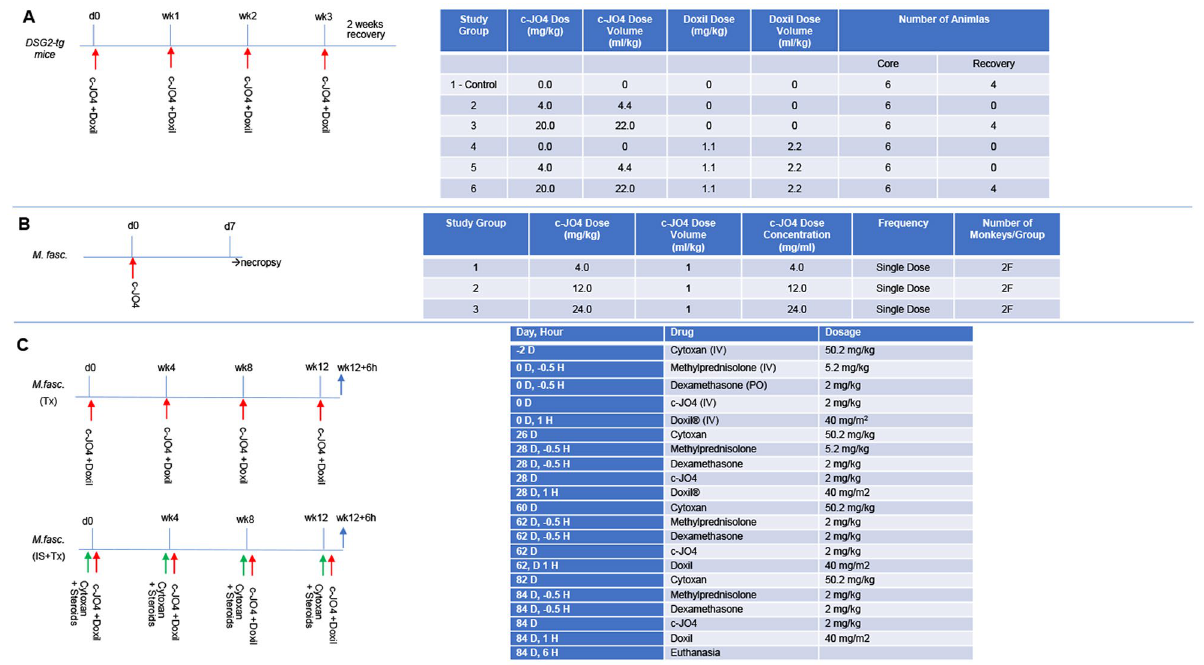
Figure 2. Summary of animal studies. ( A ) Four-week intravenous GLP-toxicology study of c-JO4 in female hDSG2-transgenic mice. The objectives of this study were to evaluate the potential toxicity of c-JO4 when administered intravenously together with Doxil to hDSG2-transgenic mice weekly for 4 consecutive weeks with 2 weeks of recovery. c-JO4 was injected intravenously one hour before intravenous injection of Doxil. The animals were approximately 5–11 weeks old and weighed 19.9–26.0 g at the time of the first dose administration. The study consisted of one control and five treated groups. Each group had 6 Core female mice (undergoing standard evaluations such as clinical observations, body weight, clinical pathology, organ weights and histopathology). In addition, 4 female mice per group in groups 1, 3, and 6 were designated as Recovery animals. The recovery animals were handled exactly as the Core mice but were held for at least 14 days of rest after the last dose to determine the reversibility of potential treatment-related effects. ( B ) Intravenous dose range finding study in female cynomolgus monkeys. Dose range study plan of c-JO4 in female cynomolgus monkeys. 3 groups of monkeys (N = 2) were administered with escalating doses of c-JO4 (4, 12, 24 mg/kg). Group 3 was dosed after no toxicity was observed at the previous dose level. Necropsy was performed at day 7 after administration of the c-JO4 dose to collect organ and tissue samples. ( C ) Non-GLP four-cycle toxicity /pharmacokinetics /immunogenicity study with c-JO4 + Doxil in cynomolgus monkeys. One animal received c-JO4 and, one hour later, Doxil as indicated (“Tx”). The second animal additionally received immunosuppressive drugs (“IS + Tx”). Immunosuppression consisted of Cyclophosphamide given 2 days before c-JO4/Doxil) and methylprednisolone + dexamethasone (0.5 hrs before c-JO4 injection). Timing and dosage of drug injection is shown on the right